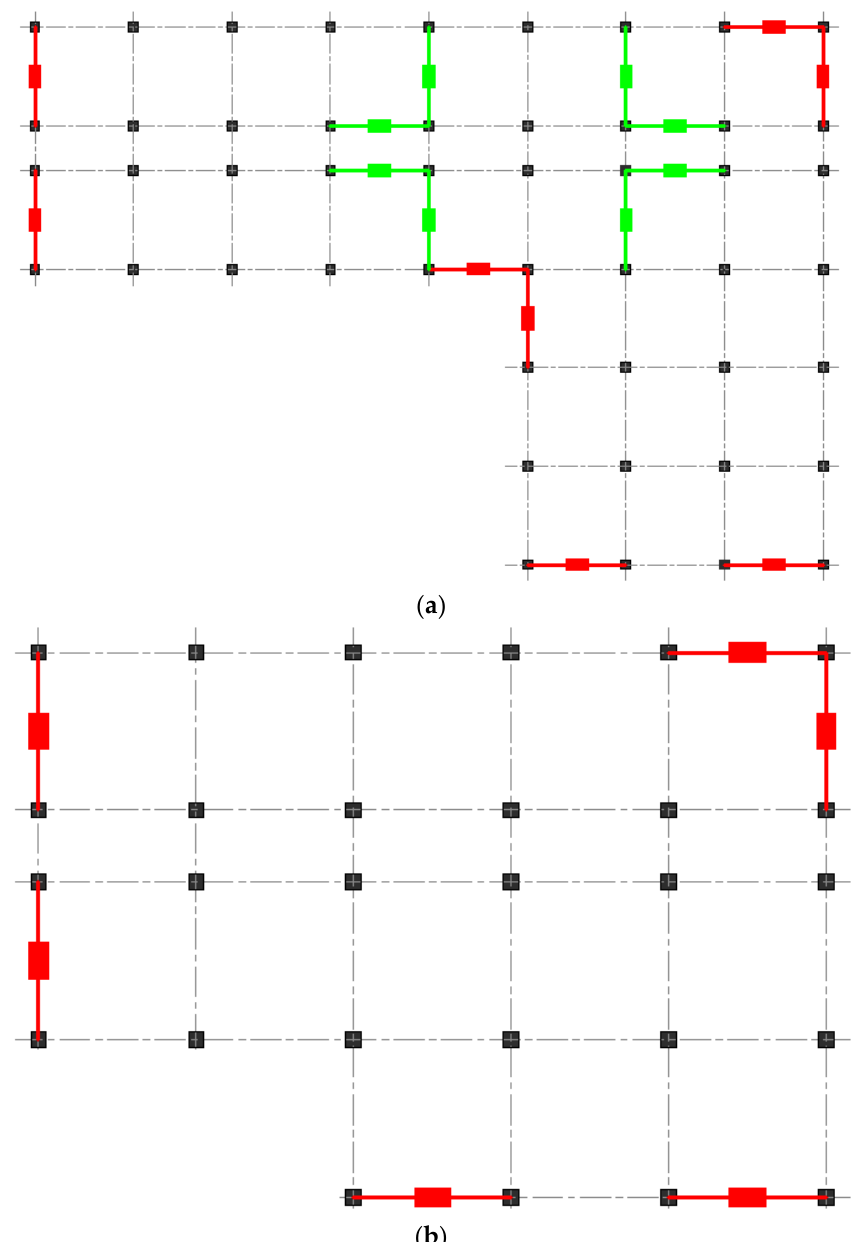
Figure 11. The placement of multiple MR dampers in different floors of the structure. ( a ) 1th–6th floor ( b ) 7th–10th floor.